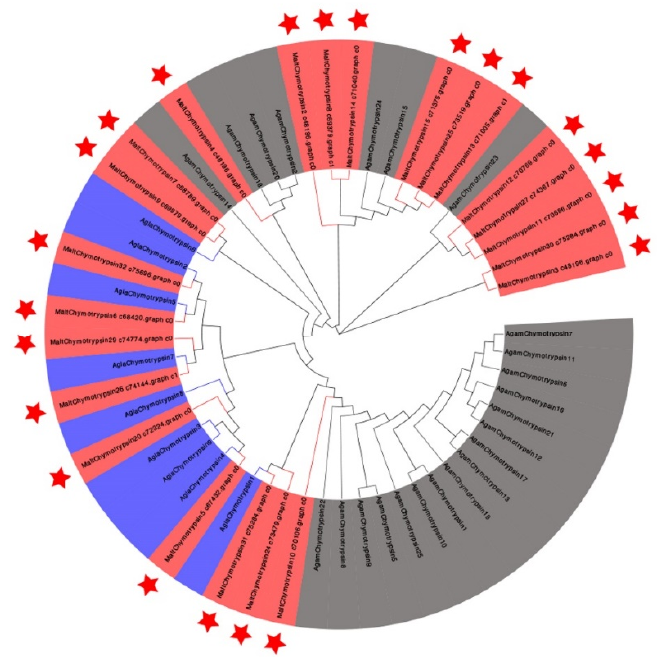
Figure 5. Phylogenetic analysis of chymotrypsin genes in Monochamus alternatus . Included are chymotrypsin from M. alternatus Hope (Malt), A. glabripennis (Agla), and A. gambiae (Agam). Chymotrypsins from different species are indicated by different colors. The chymotrypsin genes of M. alternatus are marked with red stars.